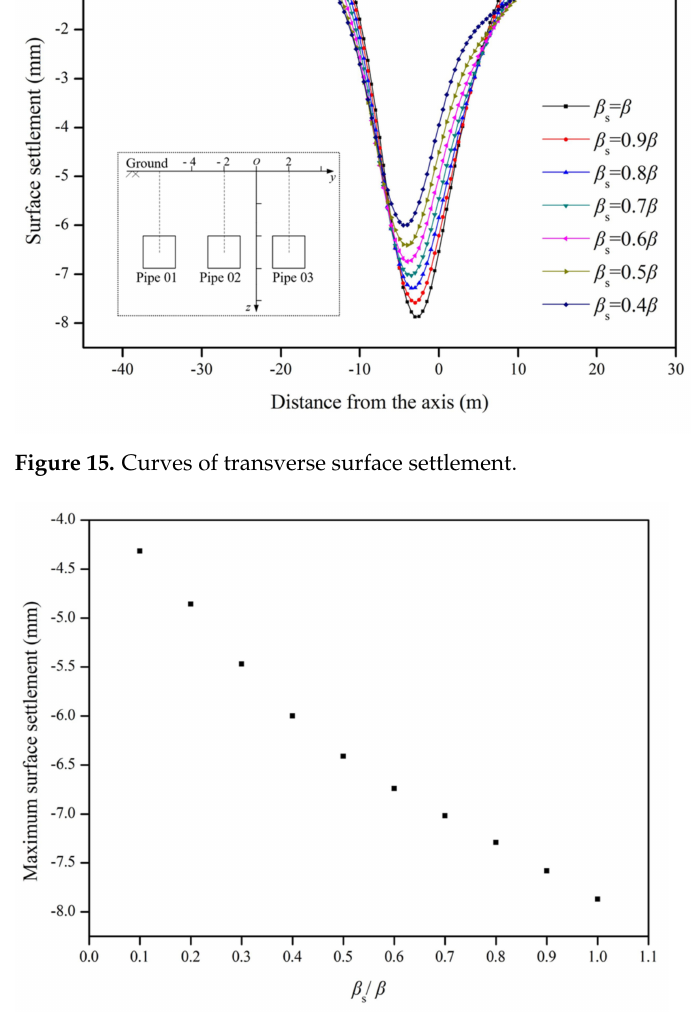
Figure 16. Variation of maximum